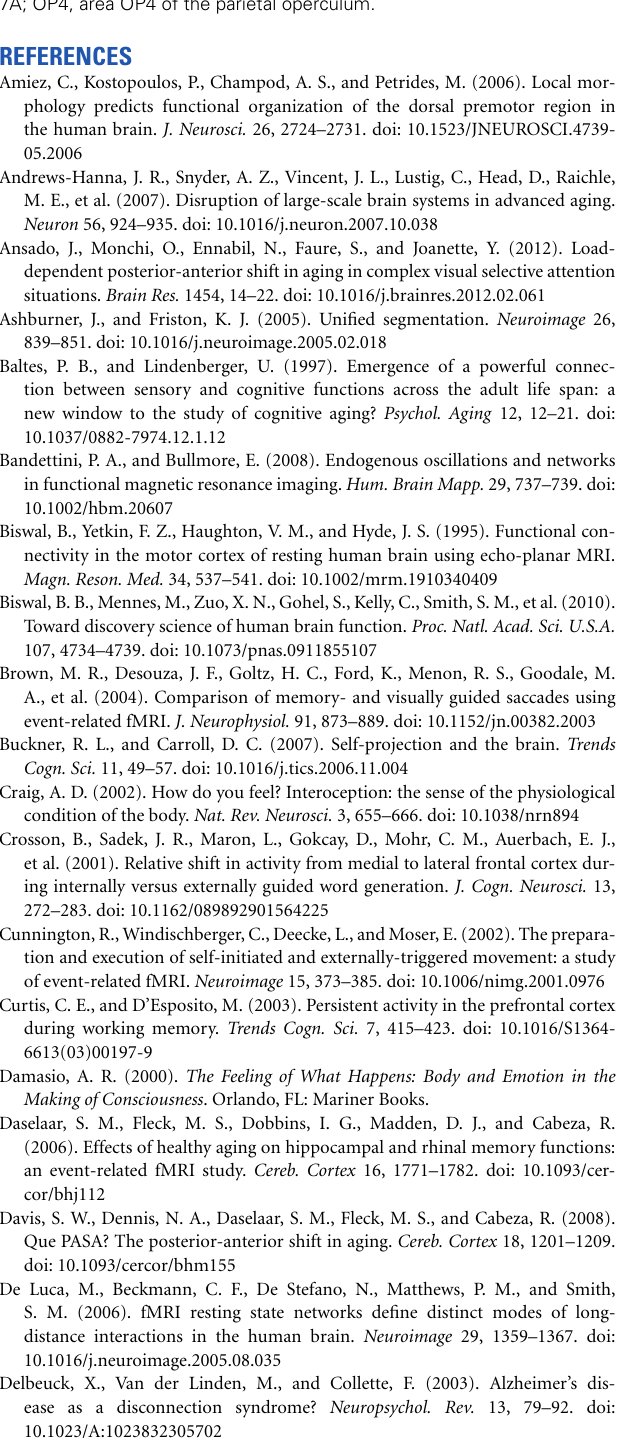
Figure S1 | Visualization of the co-activation map for each task-specific seed region as revealed by meta-analytic connectivity modeling